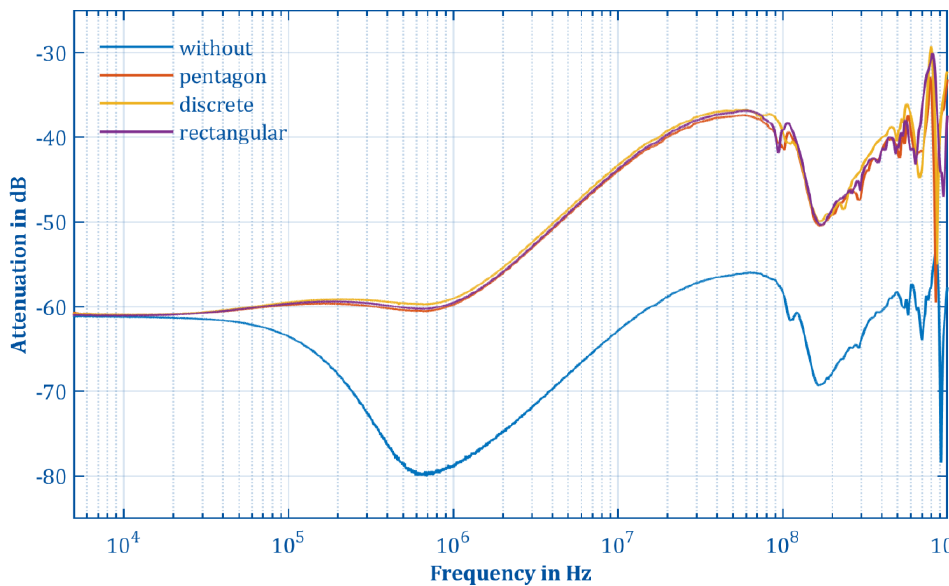
Figure 10. The measured transmission response of the resistive voltage dividers from 5 kHz to 1 GHz with different compensation electrode geometries.